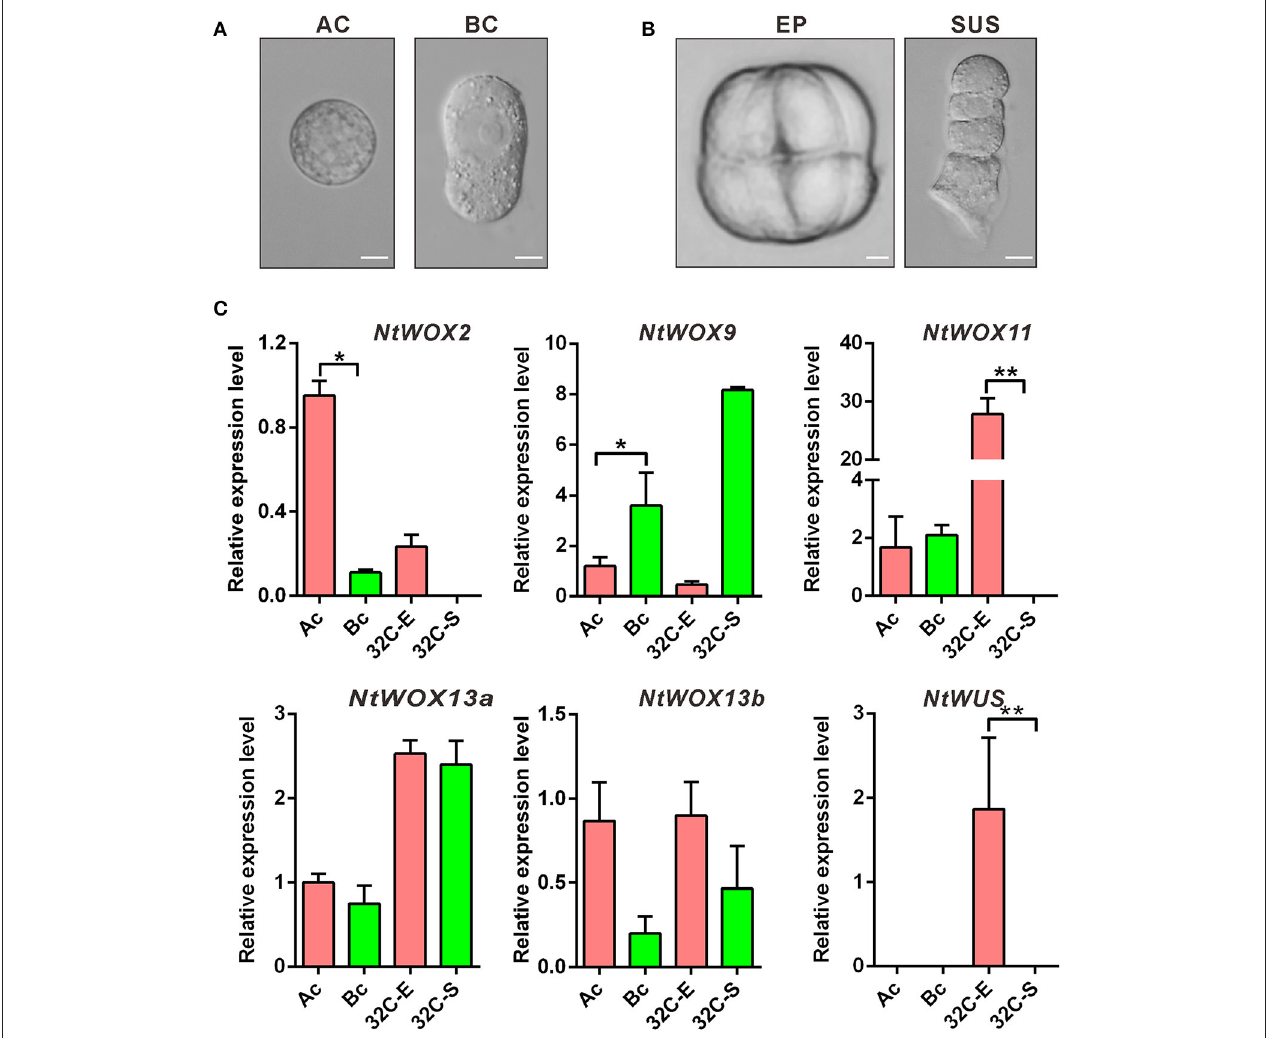
FIGURE 5 | Detection of cell type-specific expression of WOXs. (A) Isolation of apical cell (AC) and basal cell (BC), respectively. Bar = 10 µ m. (B) Isolation of embryo proper (EP) and four-celled suspensor (SUS) at 32-celled embryo stage, respectively. Bar = 10 µ m. (C) Relative expression level of each WOX in apical cell linages and basal cell linages. The expression level of each WOX (Except WUS ) in the apical cell was set as 1. The expression level was normalized to the average expression level of GAPDH (AJ133422), polyubiquitin (GQ281244), and elongation factor 1 α (AF120093). Error bars represent ± standard error from three independent experiments. Ac, apical cell; Bc, basal cell; 32C-E, embryo proper at 32-celled embryo stage; 32C-S, suspensor at 32-celled embryo